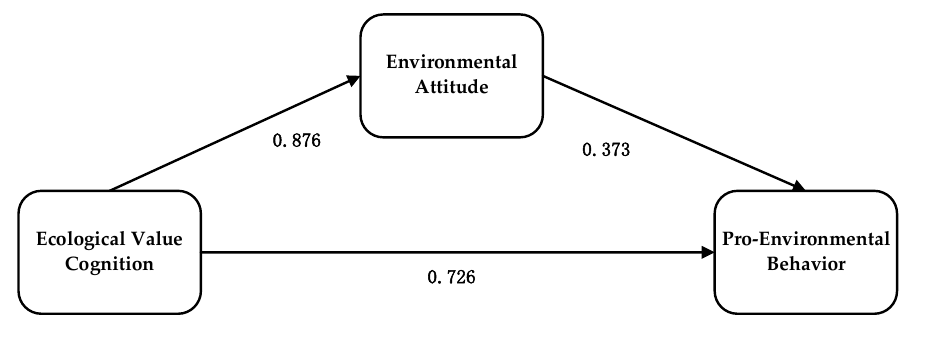
Figure 2. Pathway analysis result.